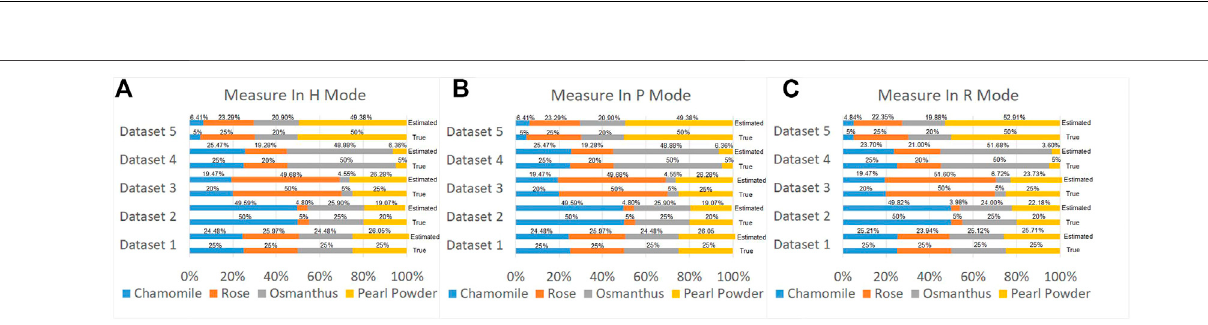
Frontiers in Physics |